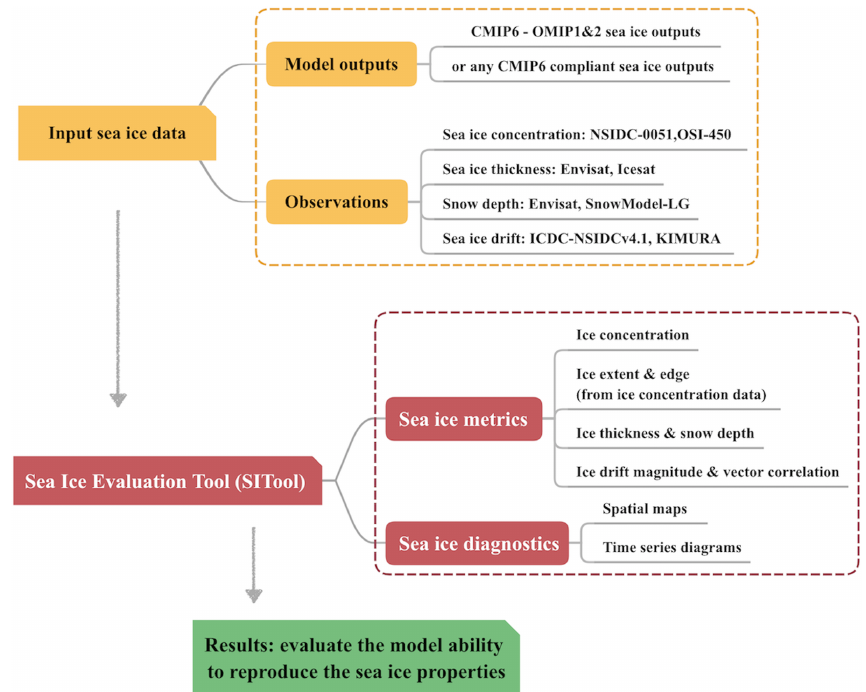
Figure 1. Schematic overview of SITool (v1.0) and its application to the CMIP6 OMIP model evaluation.